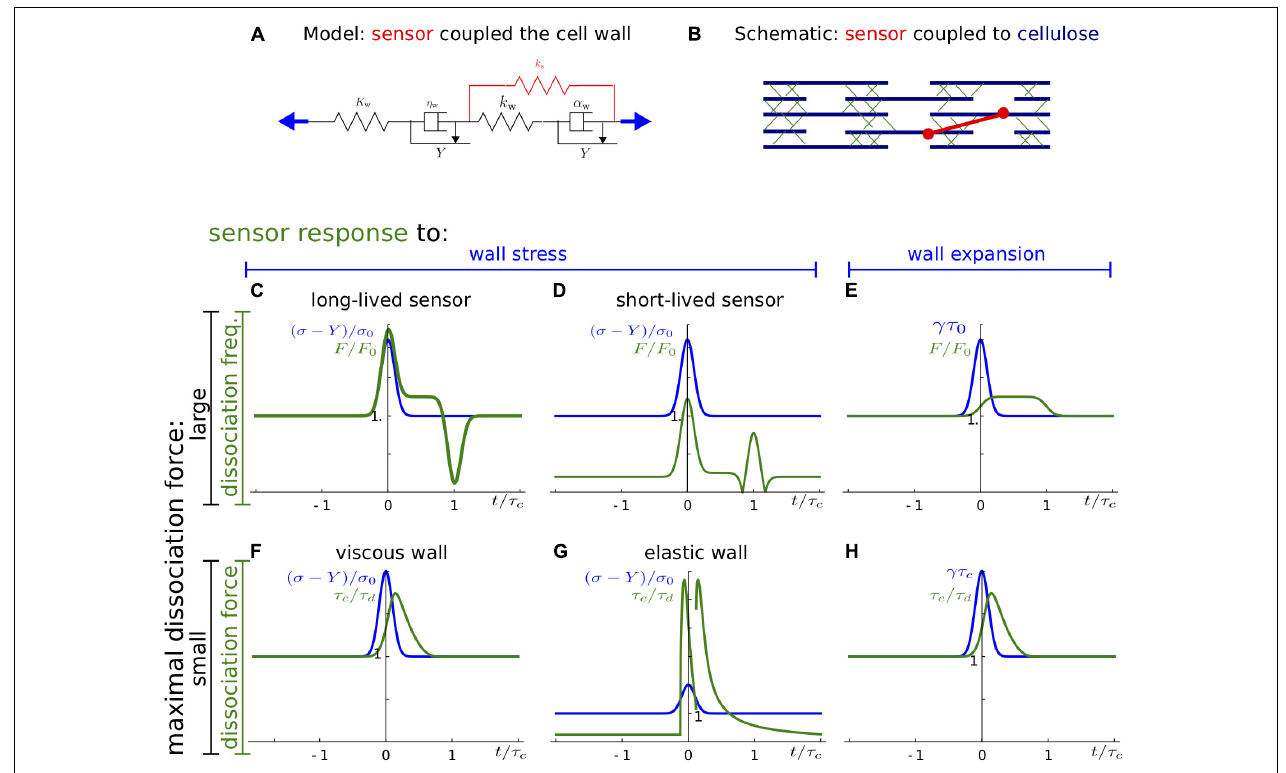
FIGURE 5 | Sensor associated with a major load-bearing structure. (A) The sensor is schematically represented as a spring in parallel to a small segment of the cell wall. K s is the spring constant of the sensor and K w and η w are the spring constant and the viscous coefficient of the corresponding segment of cell wall. (B) Schematic of the cell wall showing that the major load-bearing structure may be cellulose microfibrils. (C–H) Response of the sensor to a mechanical signal: stress (C,D,F–G) or strain/expansion (E,H) , with large (C–E) , and small (F–H) dissociation force. Mechanical signal (input, blue) and dissociation force (output, green) are plotted as a function of time. Stress is normalized using the yield threshold, Y ; and an arbitrary stress level, σ 0 ; expansion rate is normalized by 1 / τ 0 = σ 0 /( K w τ c ) in (E) and by the characteristic dissociation rate 1 / τ c in (H) ; dissociation force is normalized by F 0 = K s / K w σ 0 ; dissociation frequency 1 / τ d is normalized by 1 / τ c ; time is normalized by the dissociation time τ c . (C,D) Correspond to the ratios τ s / τ w = 0 . 2 and τ s / τ w = 1 of local to cell wall relaxation time, respectively. (F,G) correspond to a viscous and an elastic behavior of the wall. The value of dissociation force is equal to 0 . 5 k s / k w σ 0 , 0 . 5 τ c /η w σ 0 , and 0 . 5 k c in (F–H) ,